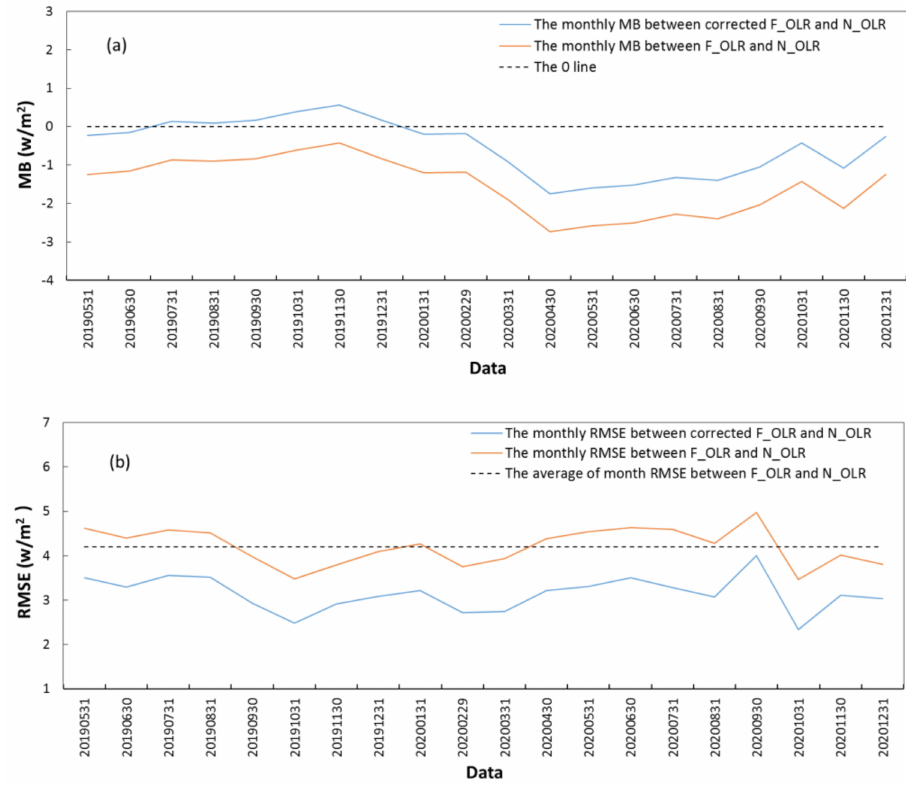
Figure 5. Variations in the global monthly average of ( a ) the MB and ( b ) the RMSE between F _OLR and N _OLR and between the corrected F _OLR and N _OLR